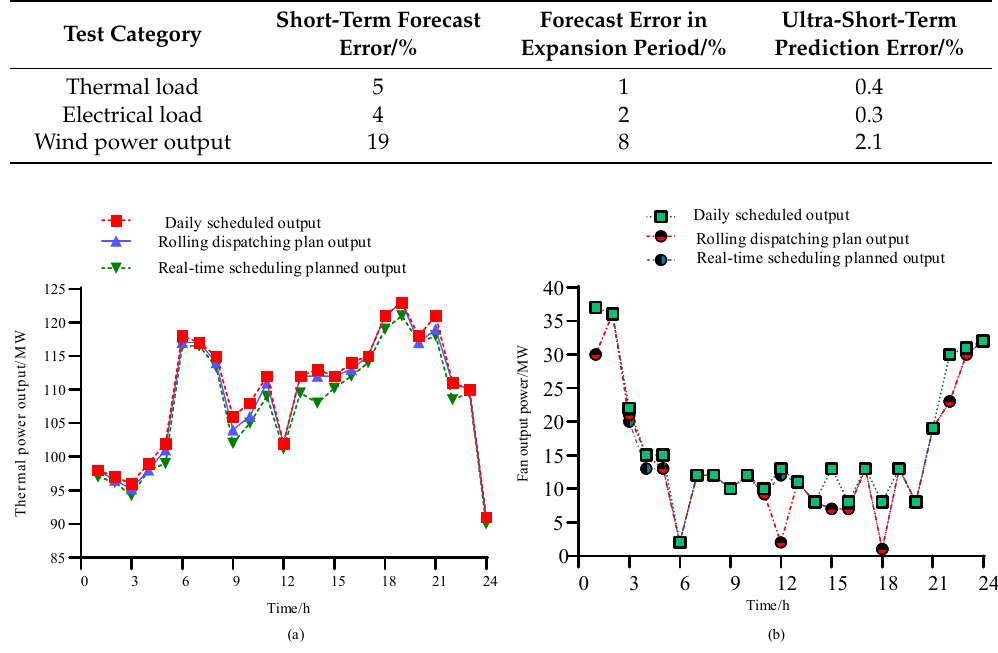
Figure A3. The results of the power data of the comprehensive energy system in different periods ( a ). Thermal power output, ( b ). Fan output